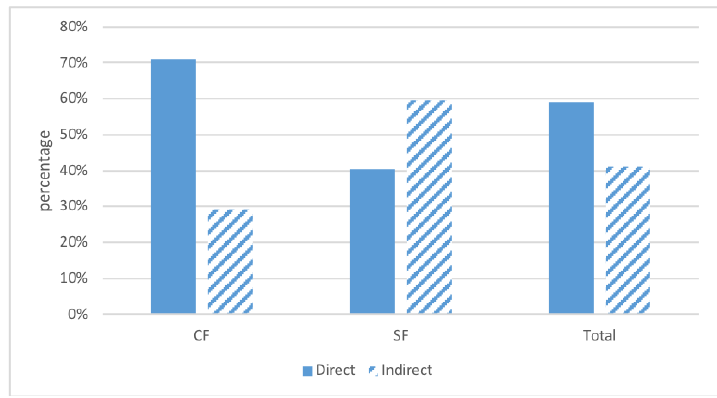
Figure 2. Support seeking strategies by forum type.